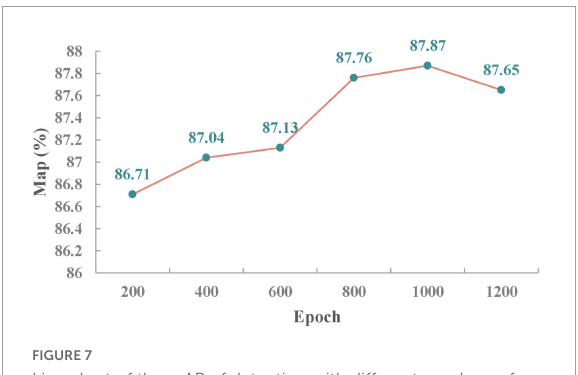
FIGURE7 Line chart of the mAP of detection with different numbers of